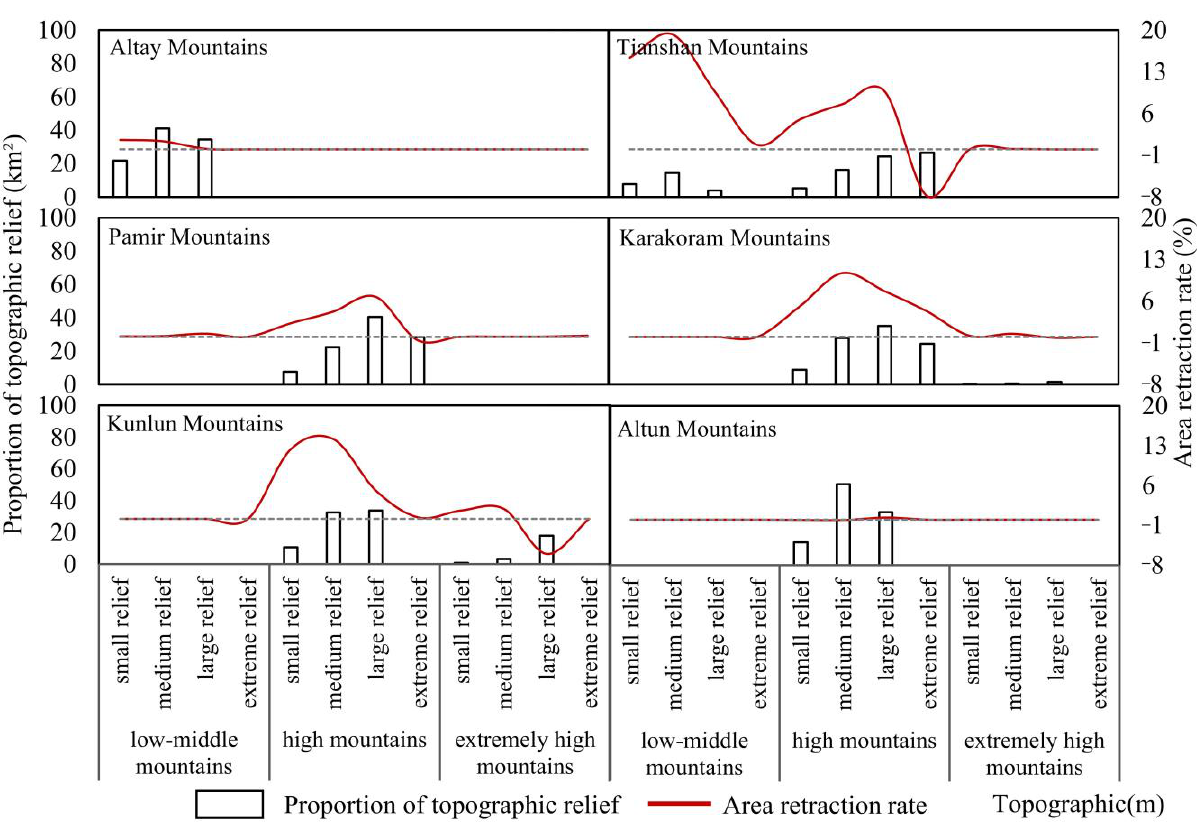
Figure 8. The proportion of topographic relief and glacier area retraction rate in each mountain of Xinjiang.